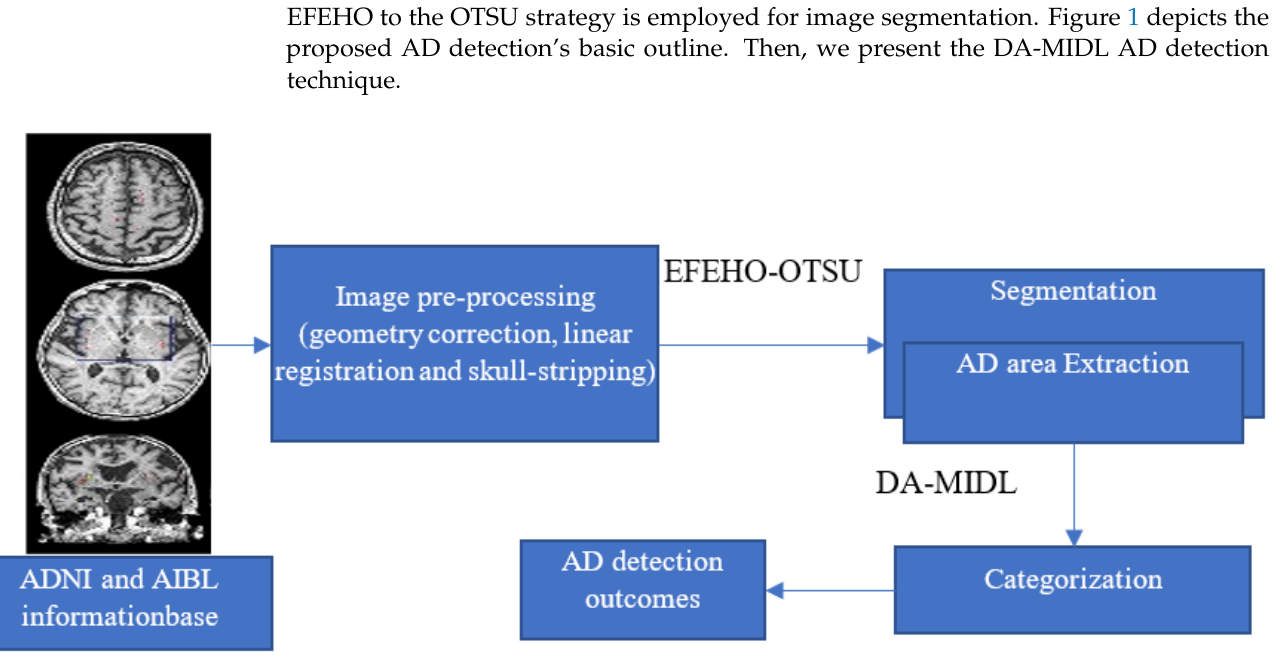
Figure 1. The basic structure of the suggested approach for AD detection.